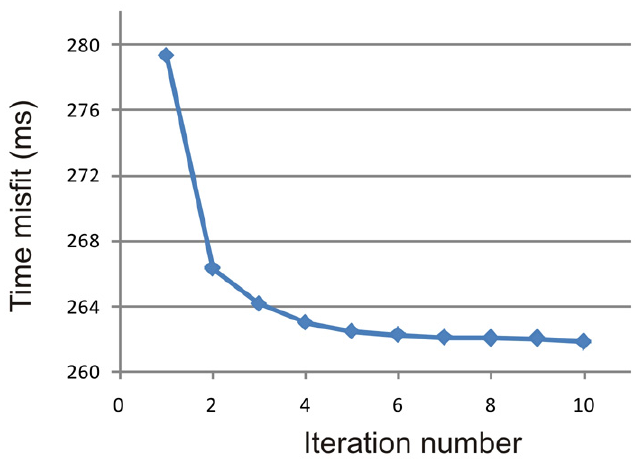
Figure 7. Time misfit for a 3D relocation as a function of the iteration